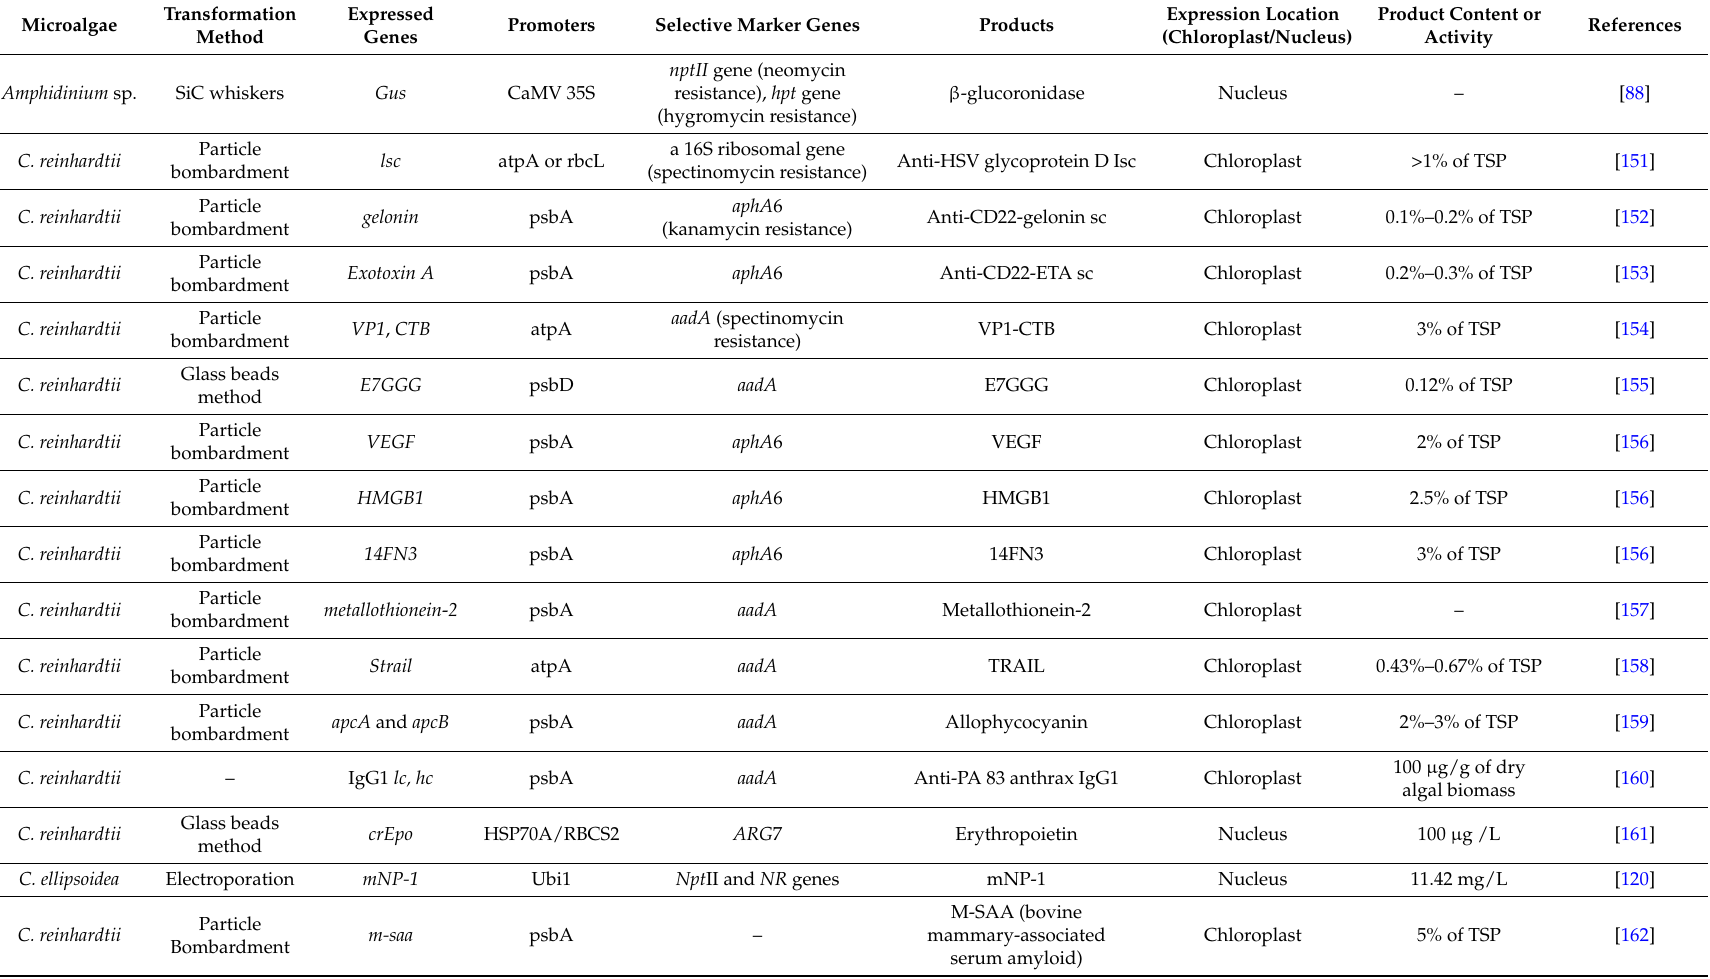
Table 3. Summary information of recombinant proteins manufactured in several important